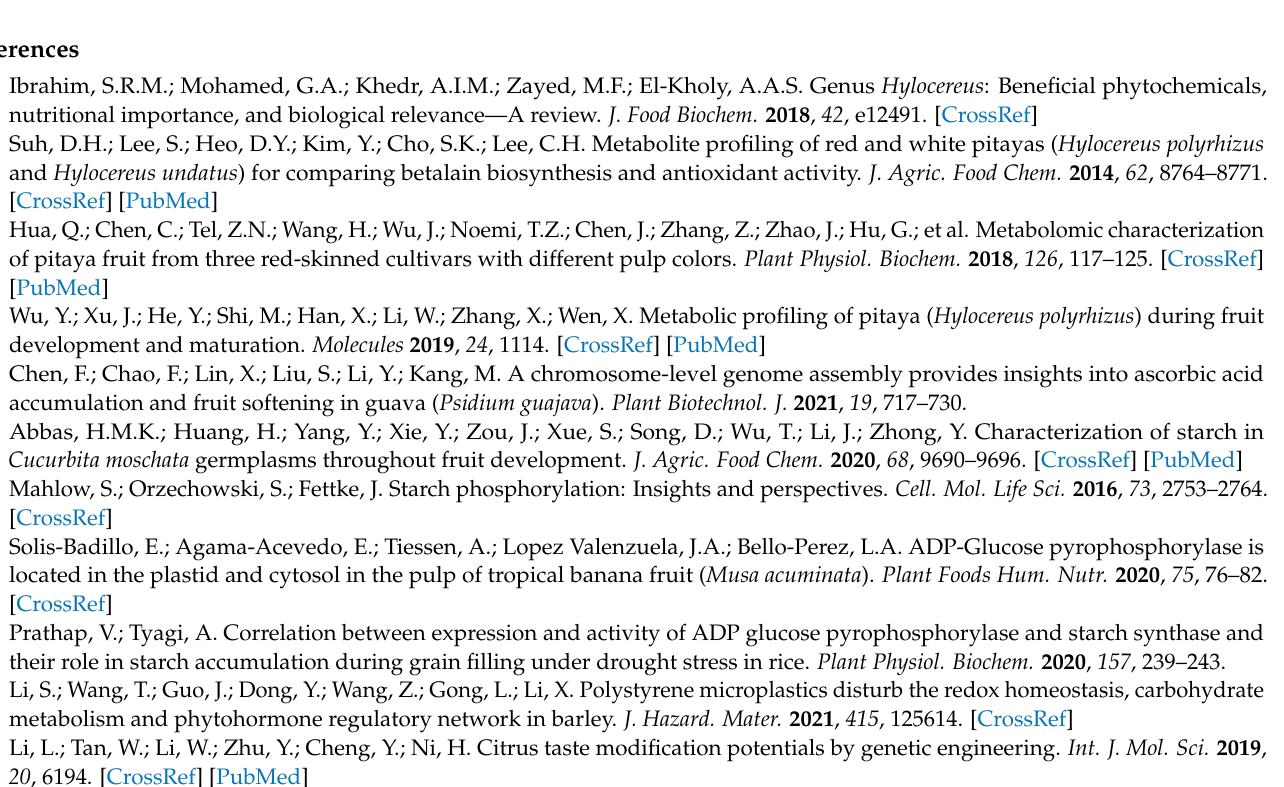
Table S9: The transcript abundance of genes related to TCA cycle pathways in ‘WCHL’ and ‘YCHL’ pitayas; Table S10: Correlation analyses between the main organic acid contents and expression patterns of candidate genes in ‘WCHL’ and ‘YCHL’